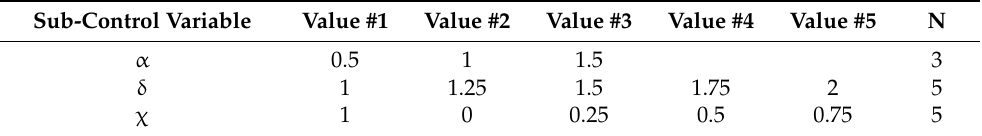
Table 5. Default sets of the three sub-control variables of the power